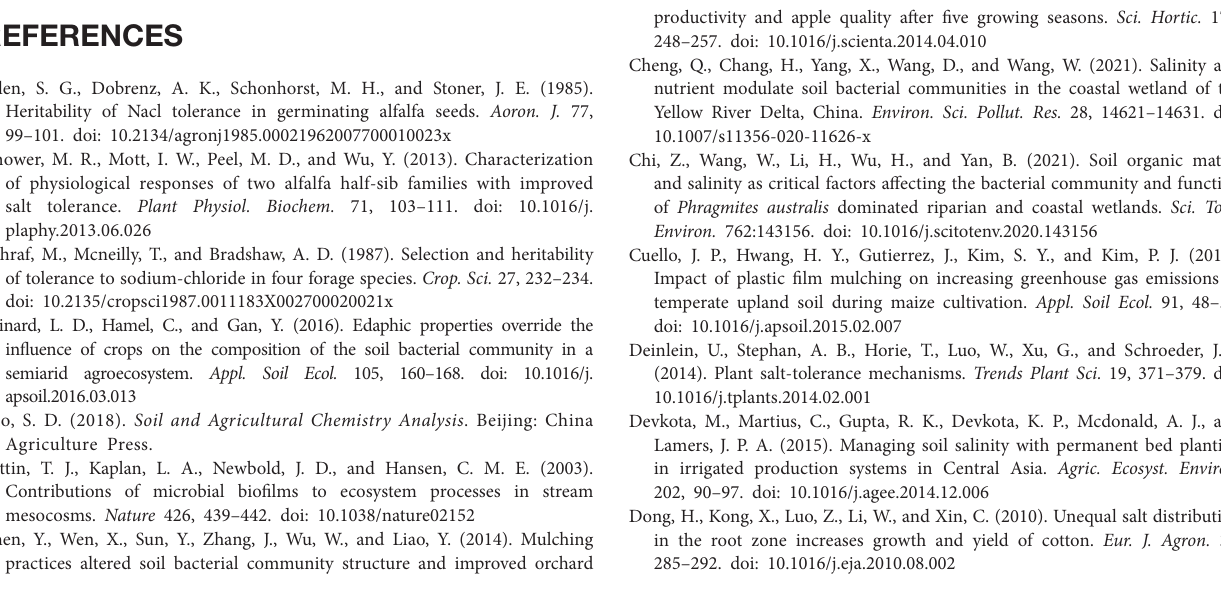
Supplementary Figure S1 | Relative abundance (% of individual taxonomic group) of dominant bacteria genera (mean ± SE, n = 4) in microbial communities following FU and FL. Different lowercase capital letters indicate statistically significant difference among communities at p =